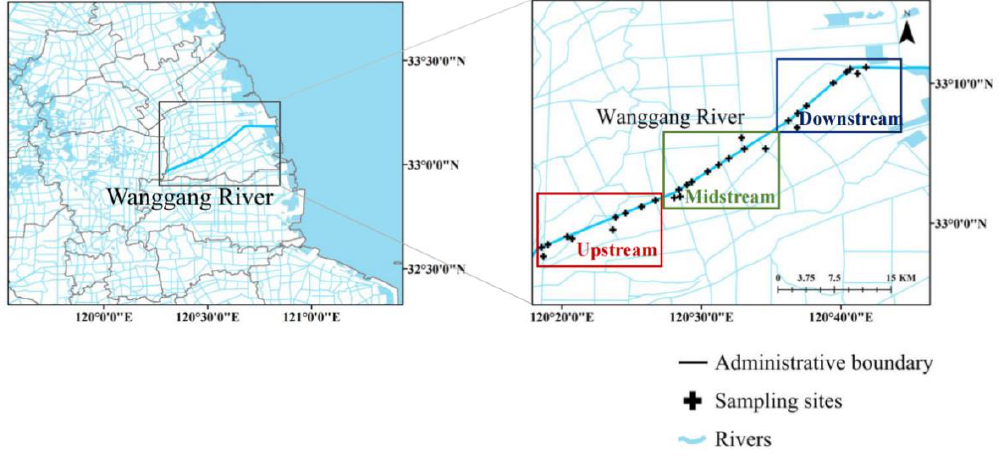
Figure 1. Map of sampling sites.